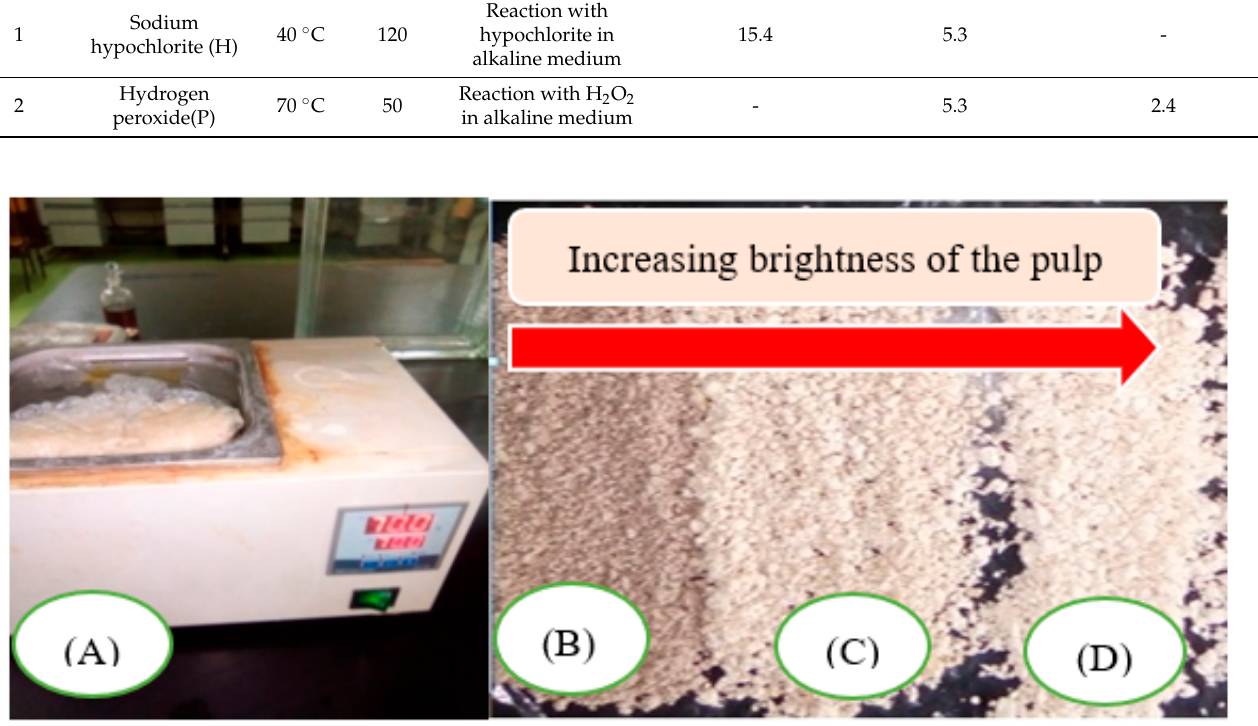
Table 4. Chemicals used in bleaching the pulp of M. azedarach . Time (min.)